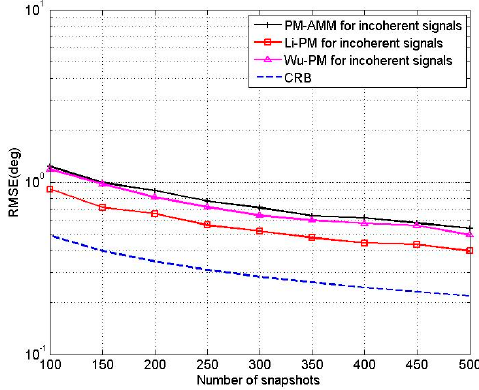
Figure 7. RMSE of PM-AMM, Li’s PM and Wu’s PM versus snapshots.